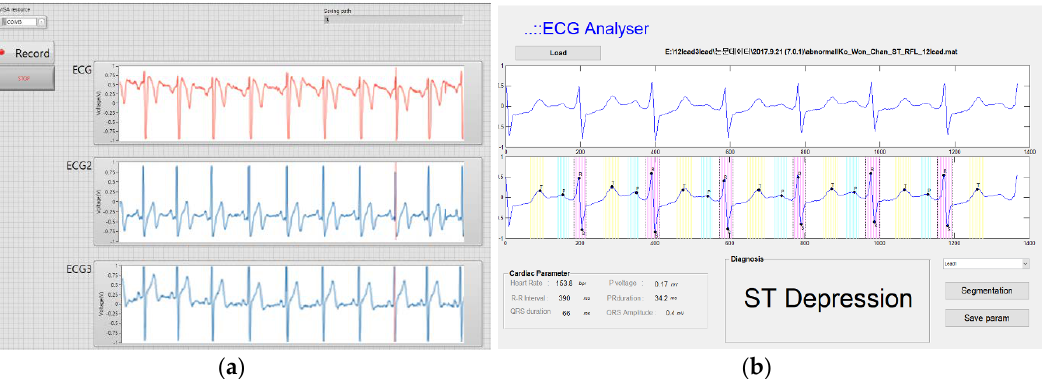
Figure 2. ( a ) Screenshot of three-lead ECG (electrocardiogram) data acquisition program. ( b ) Screenshot of ECG reconstruction and analyzing program using ECGPUWAVE.